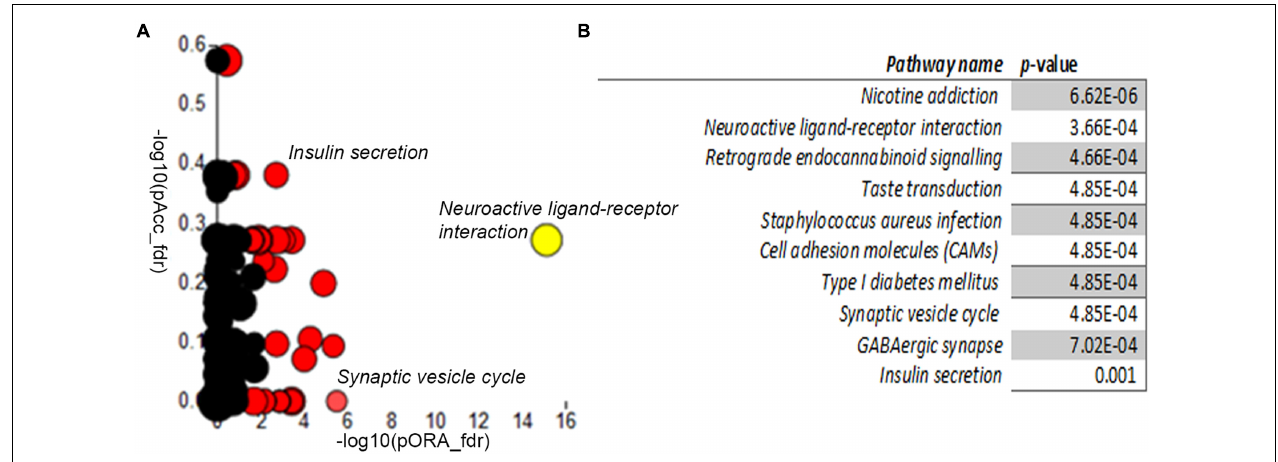
FIGURE 5 | Differential gene expression pathway analysis. Adavita iPathway Guide analysis shows statistically–significantly disrupted pathways (A) Perturbation ( y -axis) vs. Overrepresentation ( x -axis) reveals disrupted pathways further shown in (B) Table showing statistically–significantly altered pathways in AT30, compared with C11 cerebellar